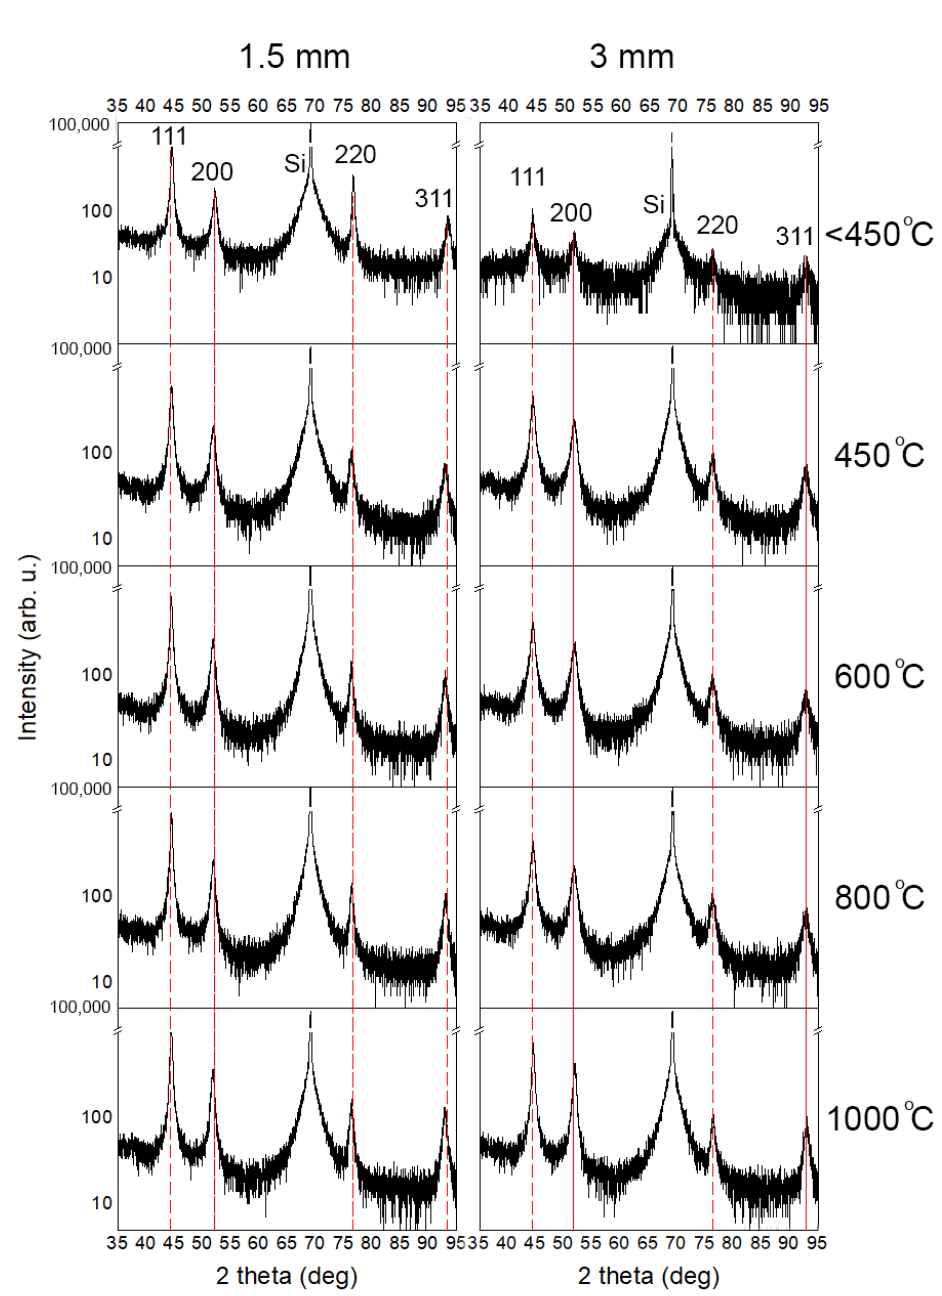
Figure 7. Diffraction patterns of nickel coatings deposited in the experiment .